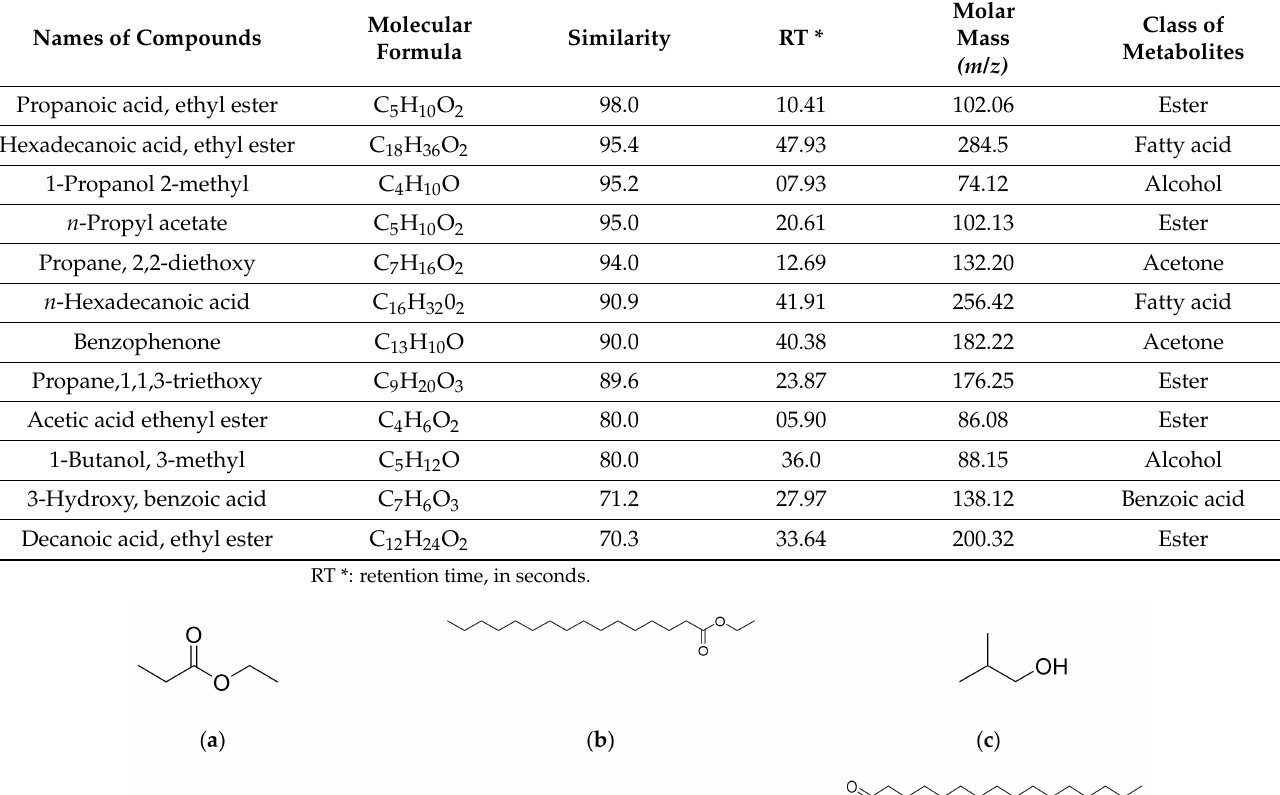
Figure 1. TIC of the HELTr according to molar mass indications, in order of retention time. Table 1. Main chemical compounds of the HELTr identified with GC-MS.